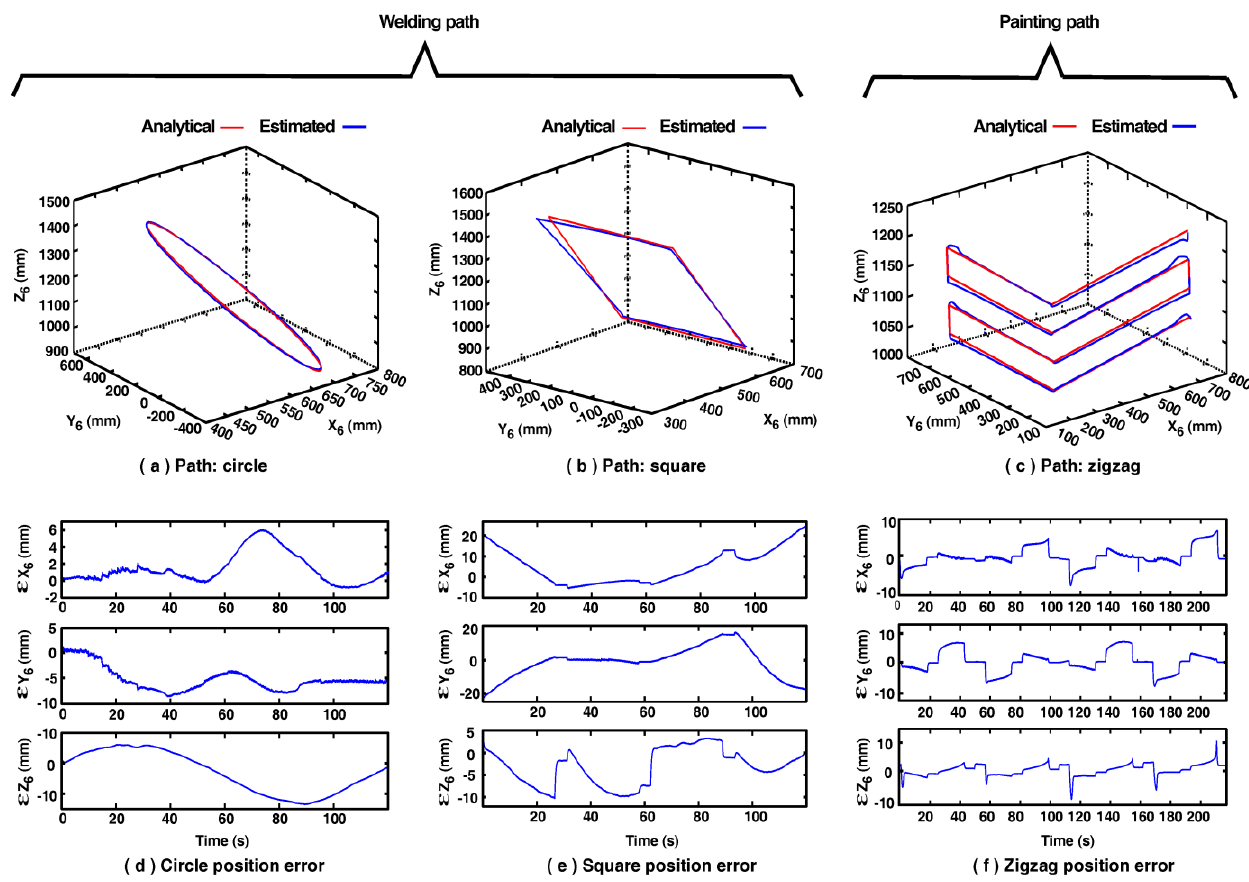
Figure 13. Analytical and estimated measures for welding and painting paths. (a) circle path, (b) square path, (c) zigzag path. Position error for (d) circle path, (e) square path and (f) zigzag